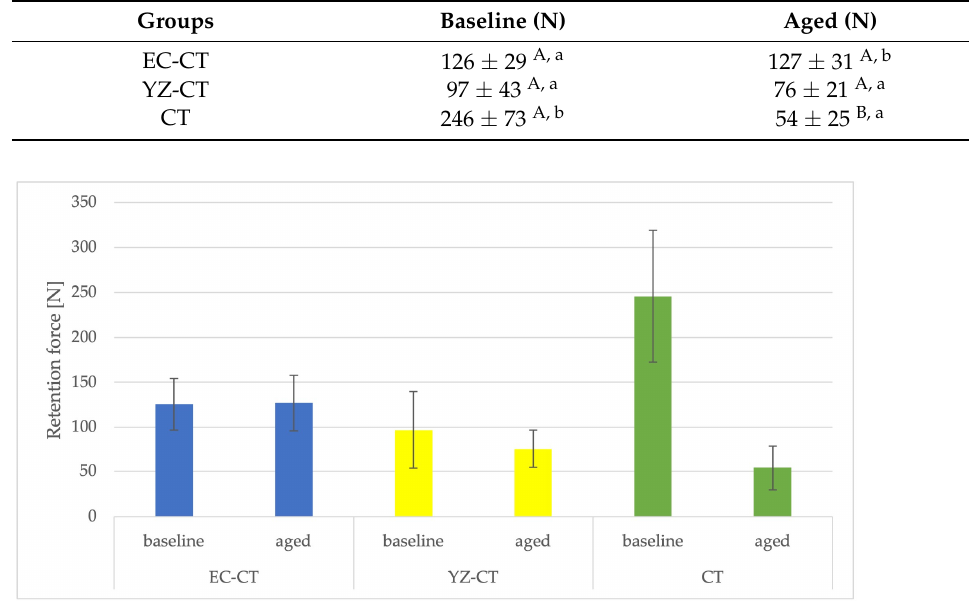
Figure 5. Retention force of the restorations ( n = 6 per group).